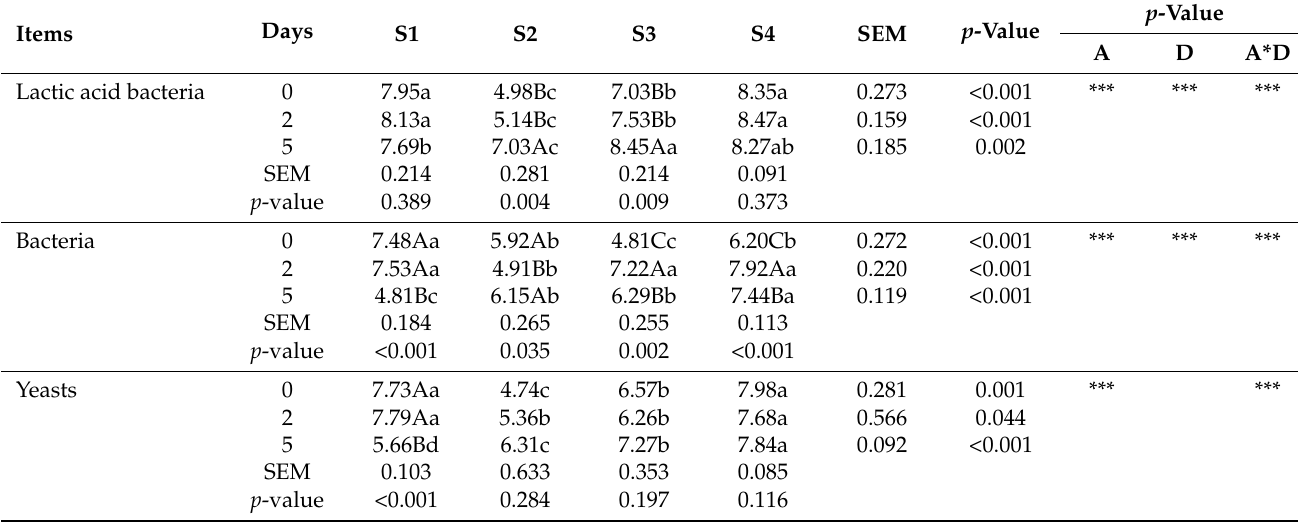
Table 2. Microbial counts (log 10 CFU/g fresh weight) of whole-plant corn silages during aerobic exposure (n = 3).